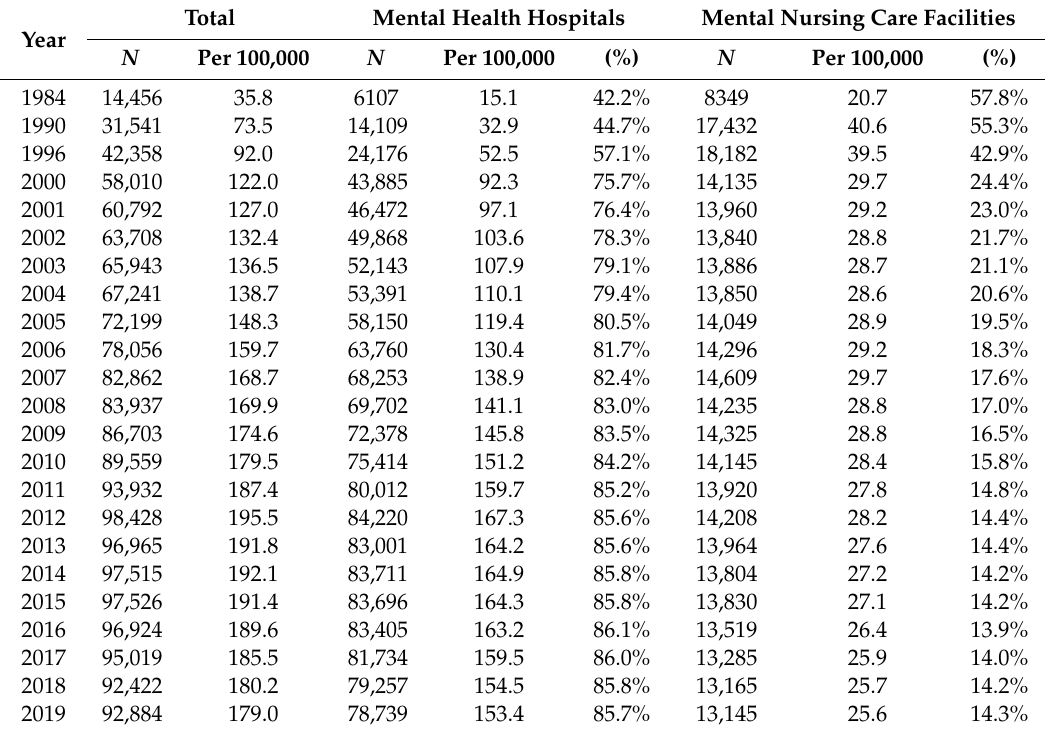
Table 2. Number of psychiatric beds (per 100,000 persons) in South